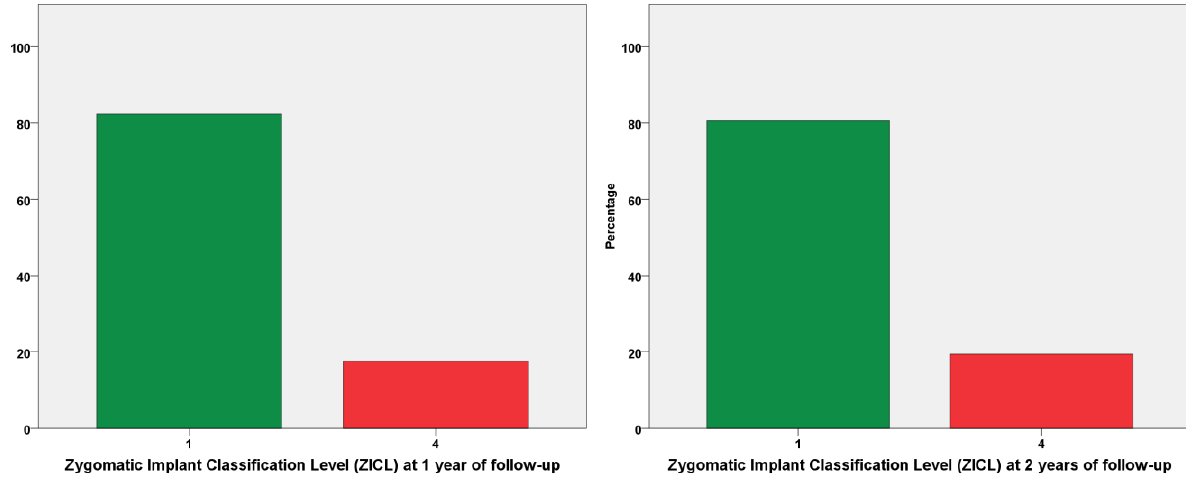
Figure 4. Modified bleeding index levels at 1- and 2-years of follow-up.